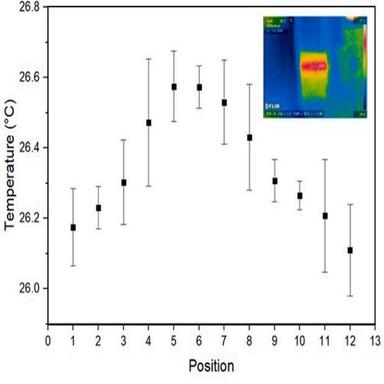
Transverse thermal field.